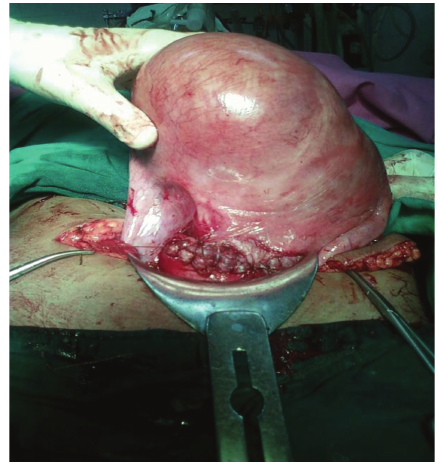
Figure 2: Detorsioned uterus with myoma after